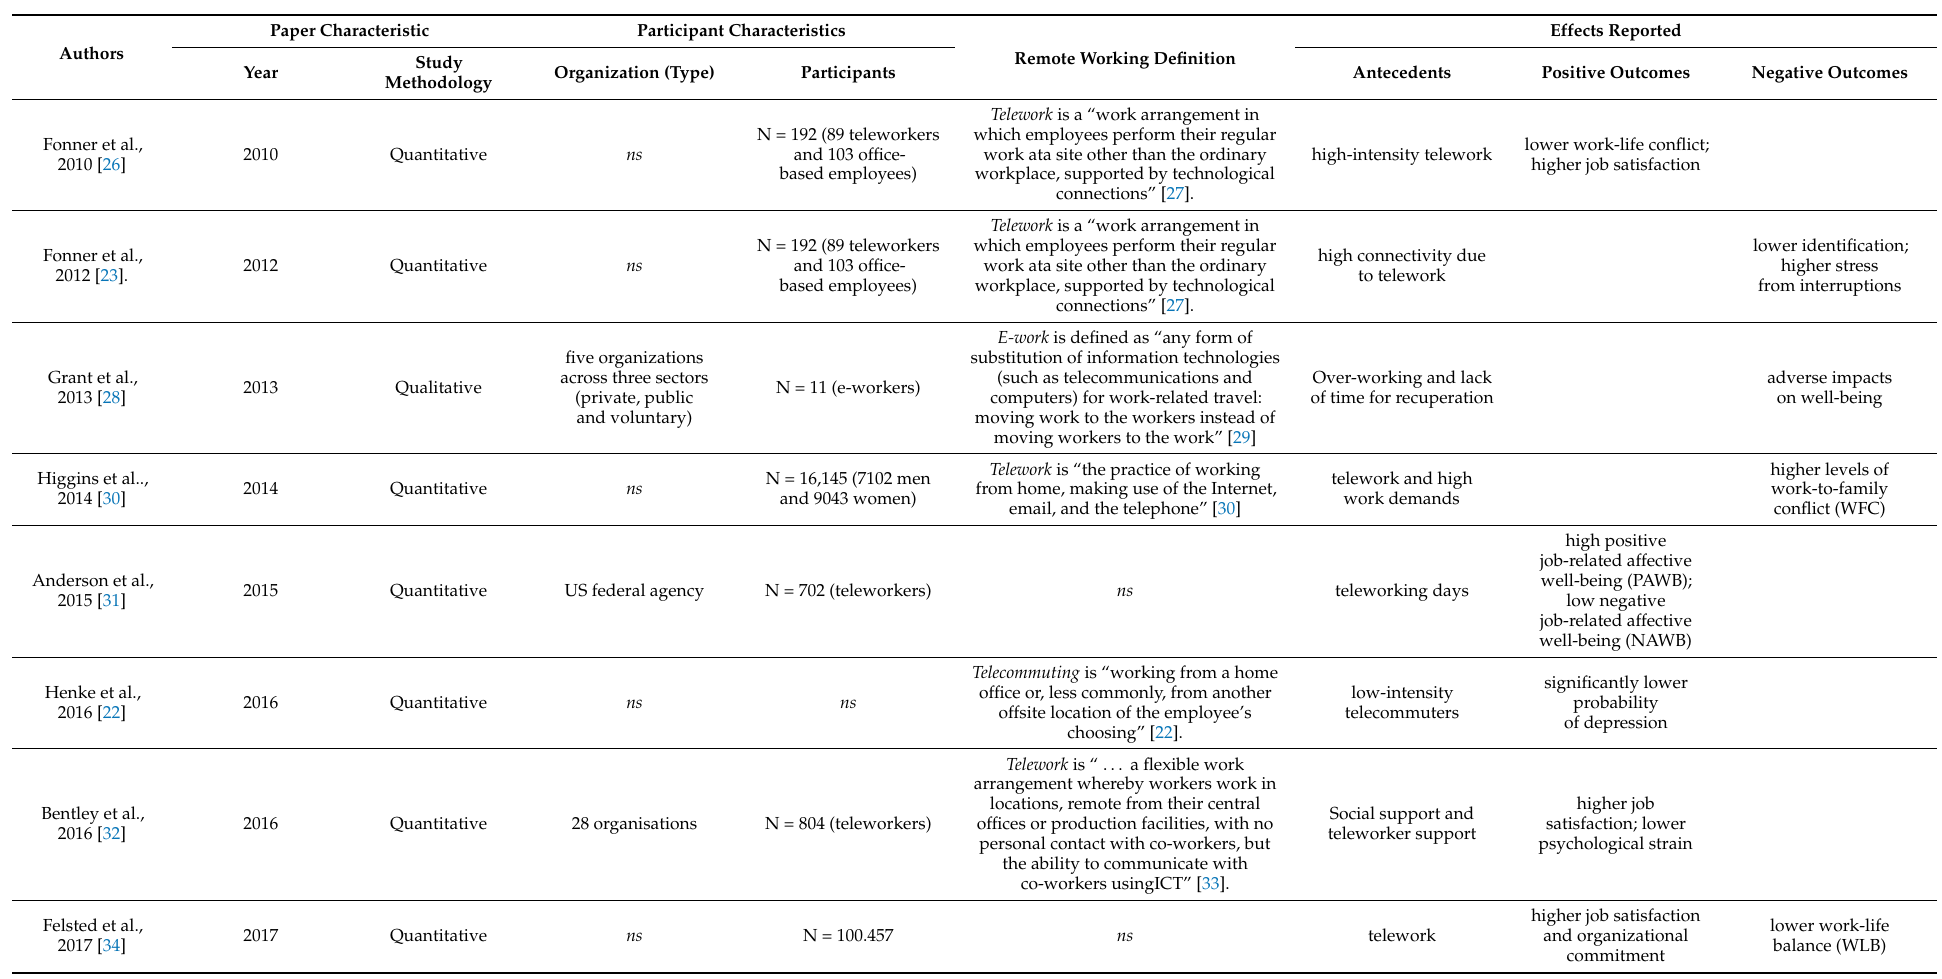
Table 1. Characteristics of included